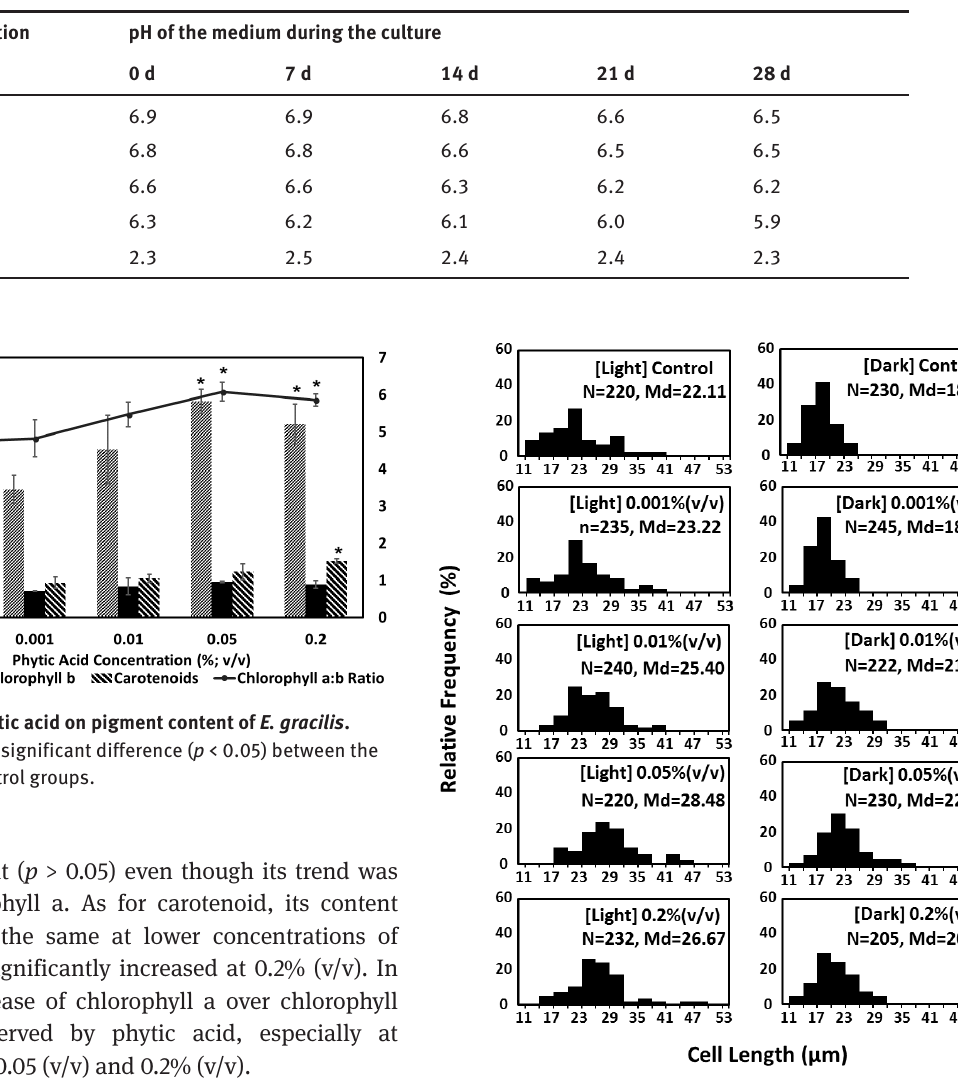
Figure 3: Effect of phytic acid on cell length distribution. [Dark] and [Light] represents the dark and light period respectively. N represents the number of samples (cell volume). Md represents the median cell